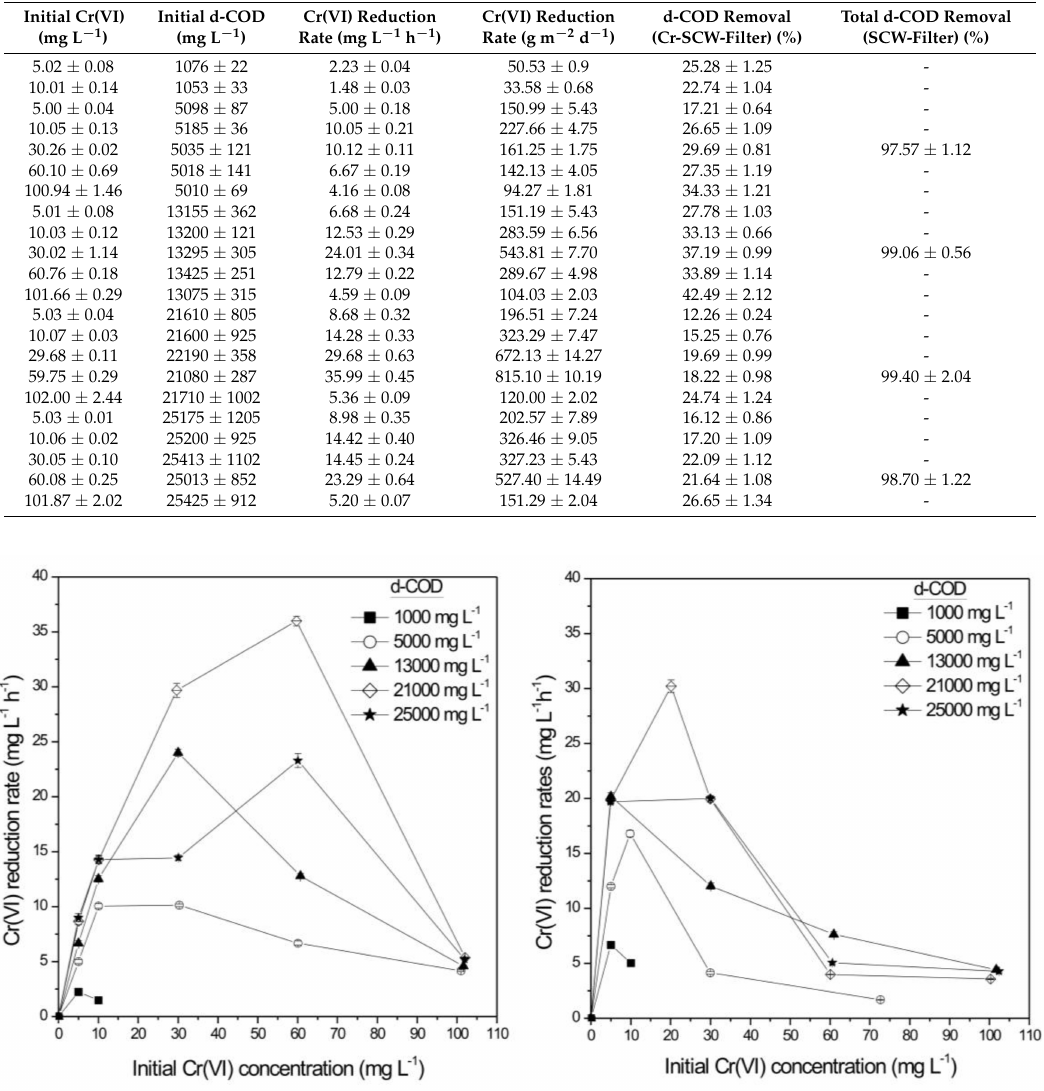
Table 1. Hexavalent chromium (Cr(VI)) reduction and dissolved chemical oxygen demand (d-COD) removal rates for the different initial Cr(VI) and d-COD concentrations tested in the Cr-SCW-filter operating under sequencing batch reactor (SBR) with a recirculation rate of 0.5 L min − 1 .